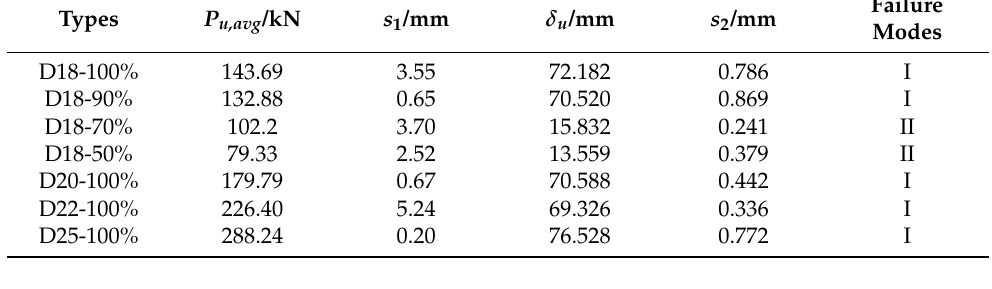
Table 4. Tensile results and failure modes.